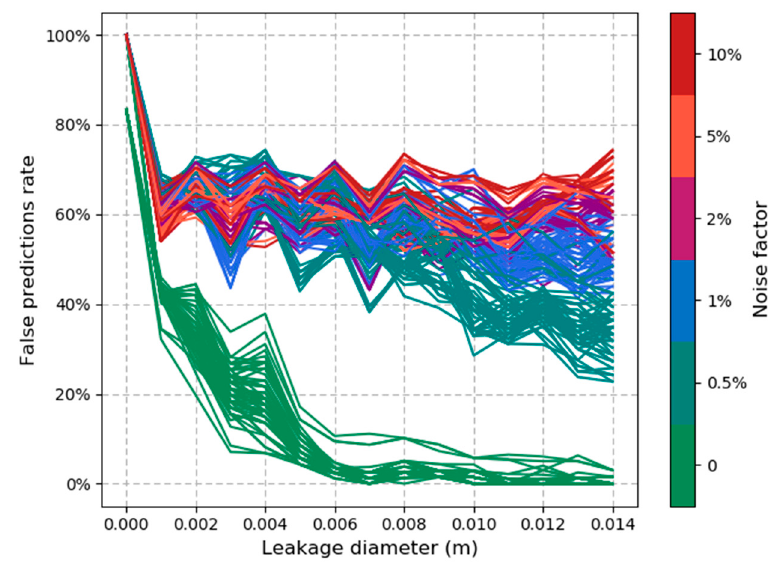
Figure 9. The impact of the noise factor on the prediction accuracy.